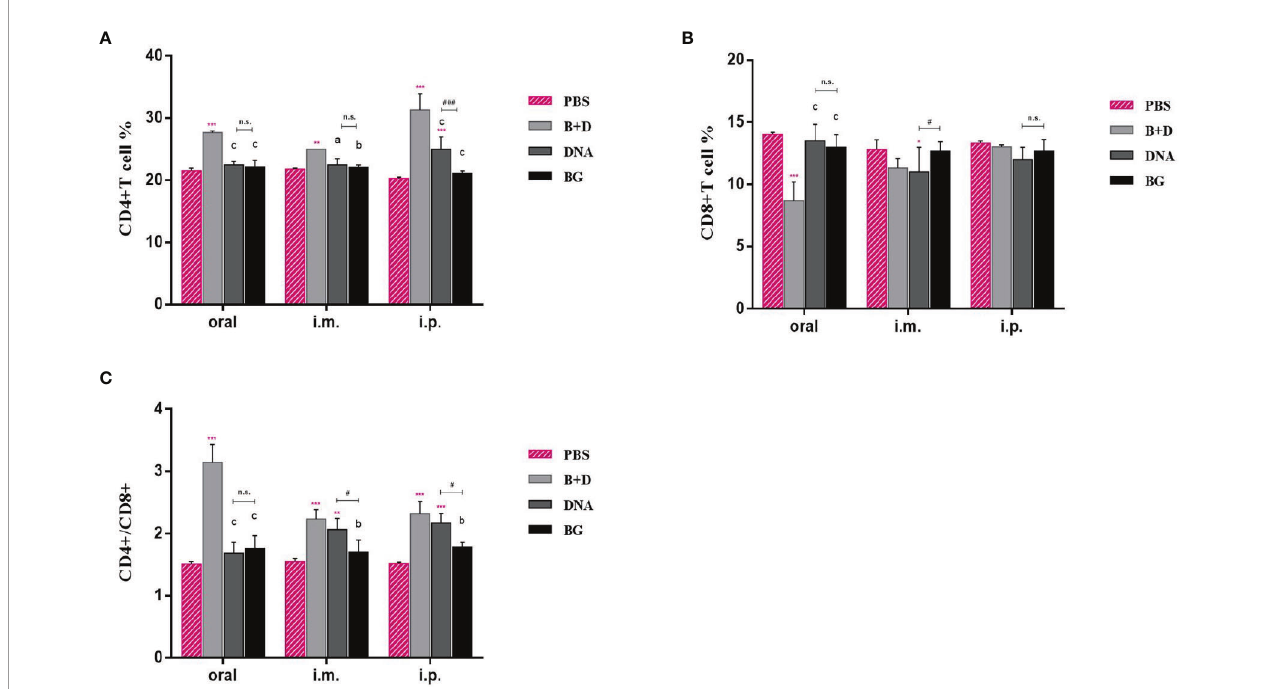
FIGURE 12 | CD4 + and CD8 + T – lymphocytes populations in immunized mice. At 14 days after the last immunization, the splenocytes of mice from each group were harvested. The percentages of (A) CD4 + and (B) CD8 + T cells were analyzed using fl ow cytometry. (C) Proportions of CD4 + /CD8 + . Values are expressed as the mean ± SD of four individual experiments. Signi fi cance of differences between the PBS, bacterial ghost (BG)+DNA, DNA, and BG groups is represented as follows: *P < 0.05, * *P < 0.01, ***P < 0.001. Letter indicates signi fi cant differences between BG +DNA, DNA, and BG groups: a P < 0.05, b P < 0.01, c P < 0.001. #Asterisk indicates signi fi cant difference between DNA and BG groups: # P < 0.05, ## P < 0.01, ### P < 0.001. n.s., no signi fi cance.